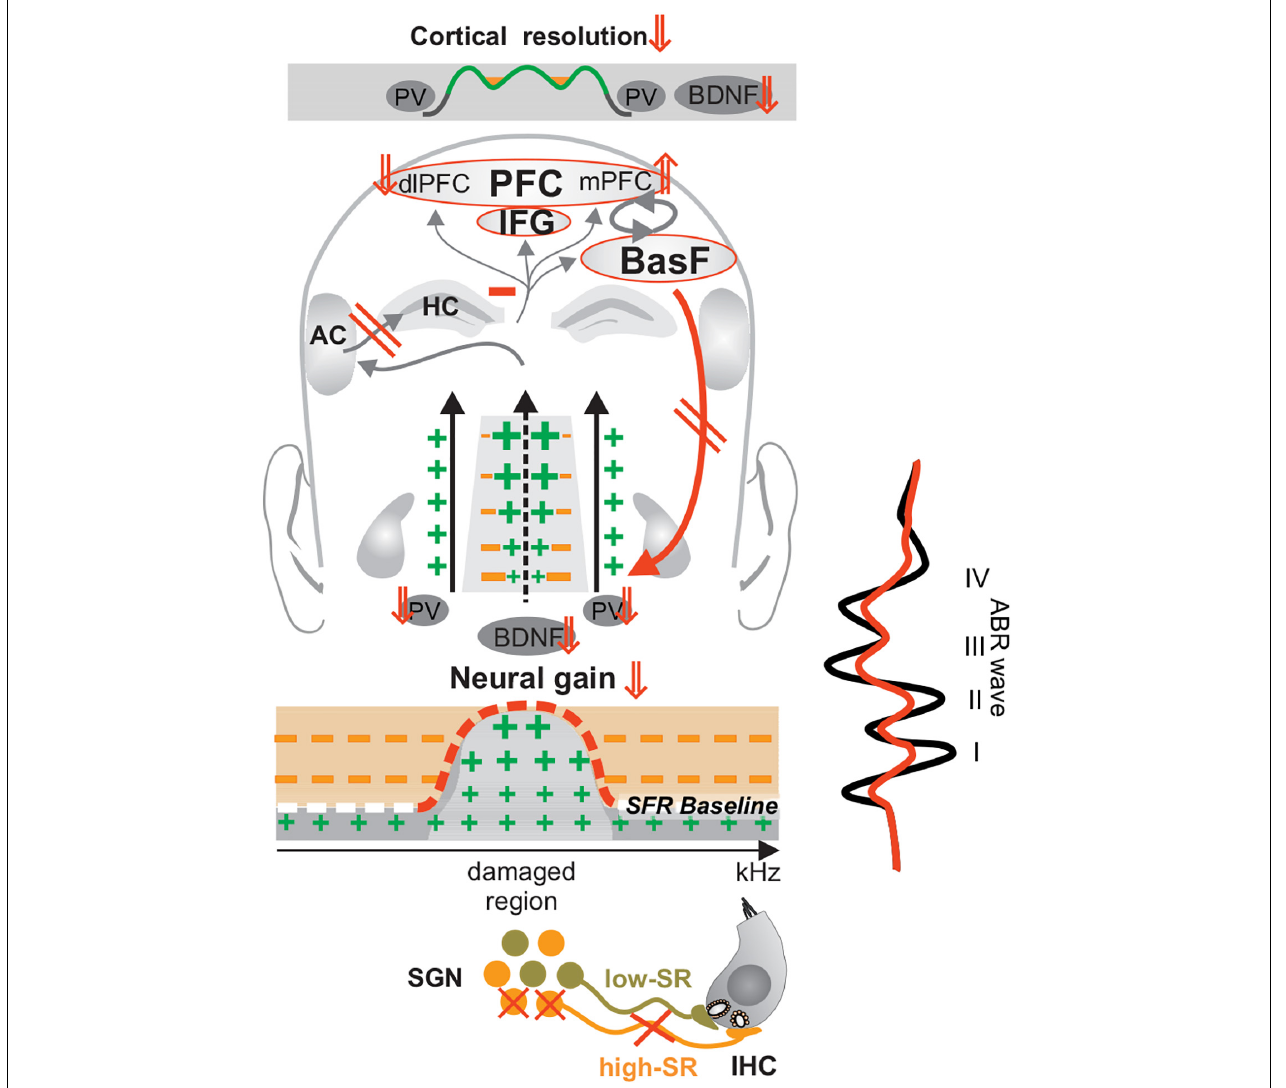
FIGURE 5 | Lost fast auditory processing following acquired deafness, trauma or tinnitus. A critical loss of high-SR fiber (orange fibers) firing may promote the re-emergence of hyperexcitability (enhanced green crosses) in affected frequency regions through the loss of tonic inhibitory PV-IN activity (reduced orange minus) subsequent to a decrease of recruitment of activity-dependent BDNF. The subsequent elevation of basal spontaneous firing rates suggests an unbalanced prefrontal stress control (mPFC ⇑ , dlPFC ⇓ , negative feedback mechanism, and red downward arrow), which may contribute to a lack of compensation of altered auditory input (red ABR wave), further alertness and distress to, e.g., manifestations of phantom noise. Modified after Knipper et al. (2020). IHC, inner hair cell; SGN, spiral ganglion neuron; SFR, spontaneous firing rate; HC, hippocampus; IFG, inferior frontal gyrus; BasF, basal Forebrain; PFC, prefrontal cortex; dlPFC, dorsolateral PFC; mPFC, medial PFC; AC, auditory cortex; PV,